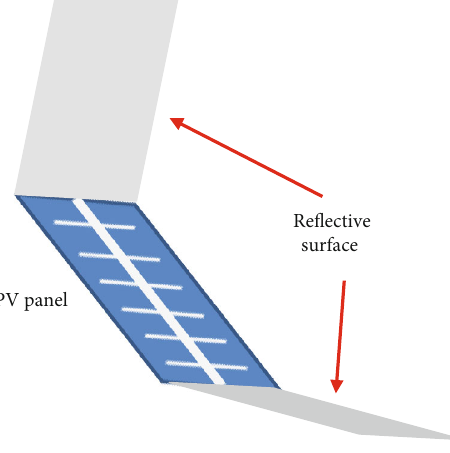
Figure 5: PV panel with mirror